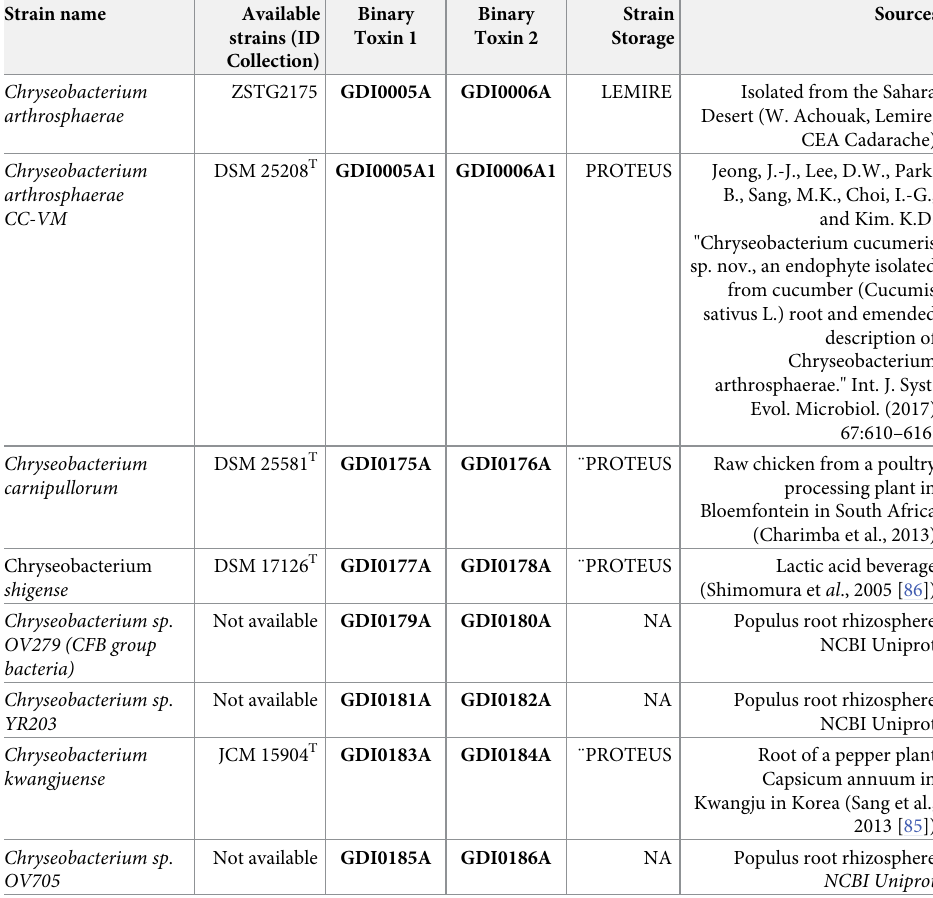
Table 3. Origin and characteristics of the Chryseobacterium strains studied for pesticidal